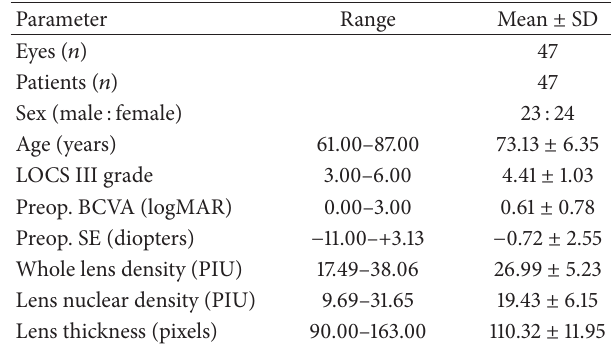
Table 1: Patient demographic